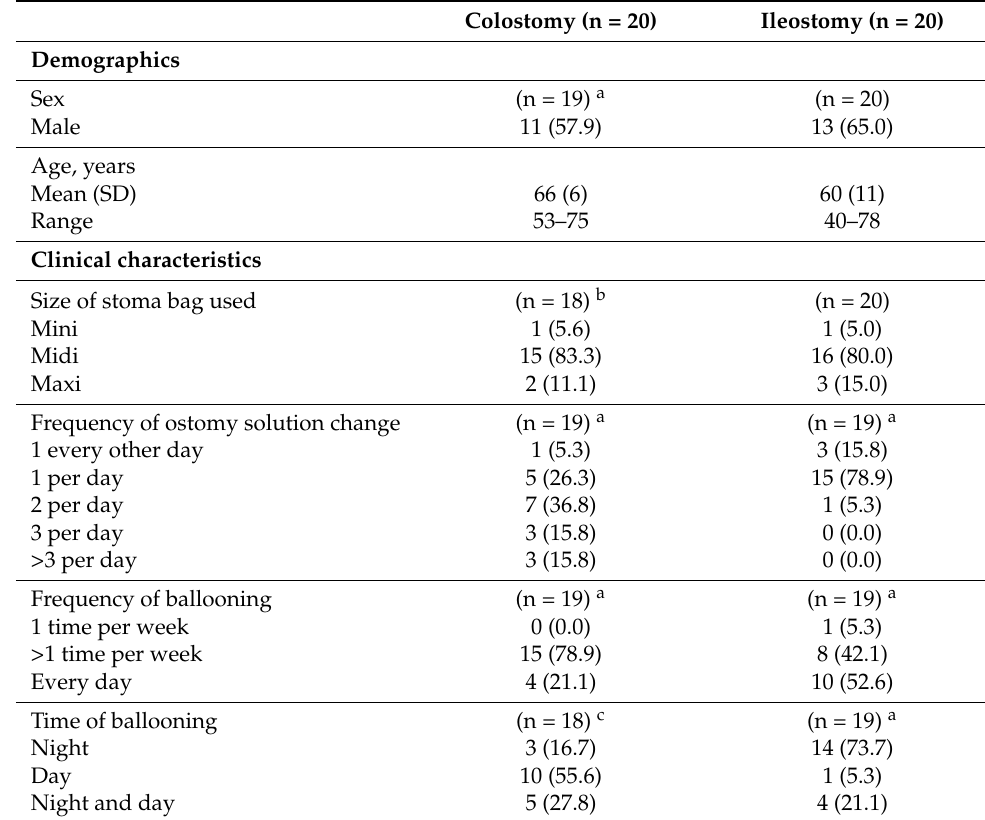
Table 1. Baseline demographics and clinical characteristics.